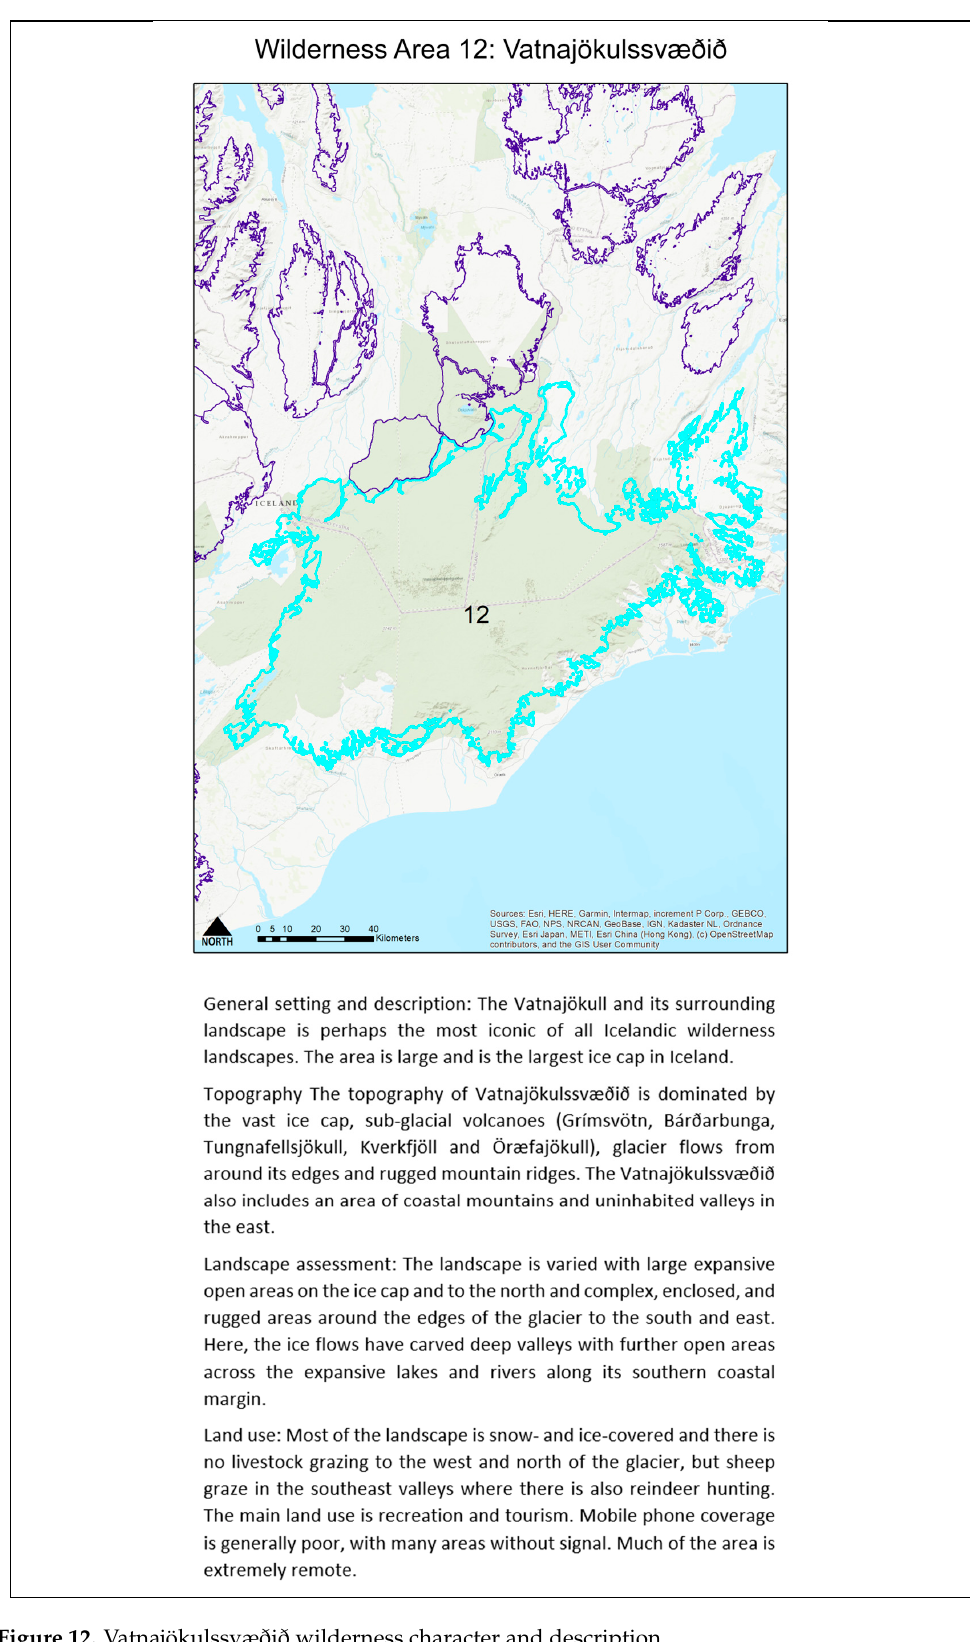
Figure 12 . Vatnajökulssvæðið wilderness character and description . Figure 12. Vatnajökulssvæðið wilderness character and